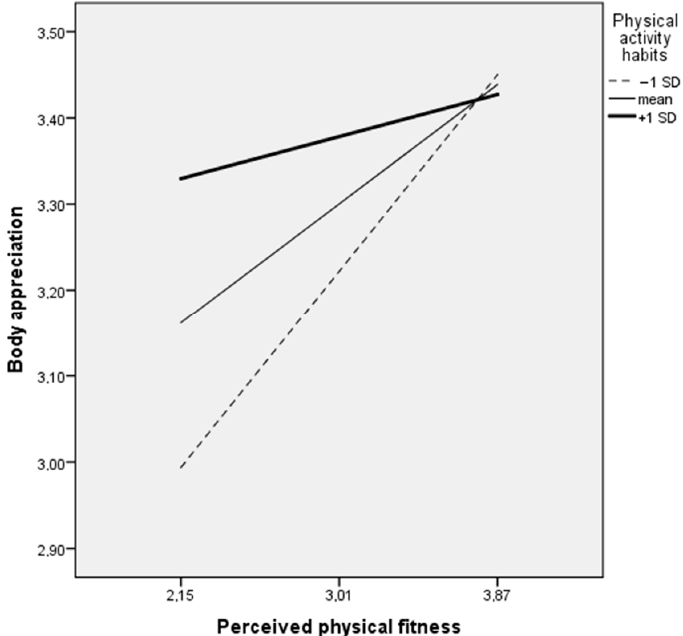
Figure 5. Visualisation of physical activity habits moderating effect in the association between perceived physical fitness and body appreciation (n = 371).